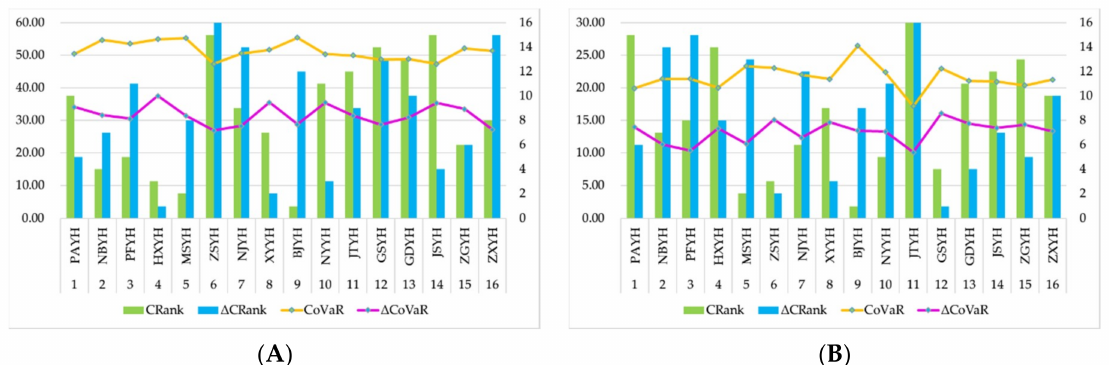
Figure 4. The results of CoVaR and ∆ CoVaR (In the figure, the CoVaR refers to the Conditional Value at Risk when a bank is in distress; ∆ CoVaR refers to the di ff erence between the CoVaRs when the bank is in distress and in a normal state): ( A ) 2015; ( B )